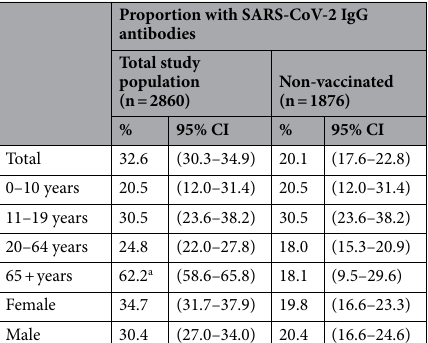
Proportion with SARS-CoV-2 IgG antibodies Total study population Non-vaccinated